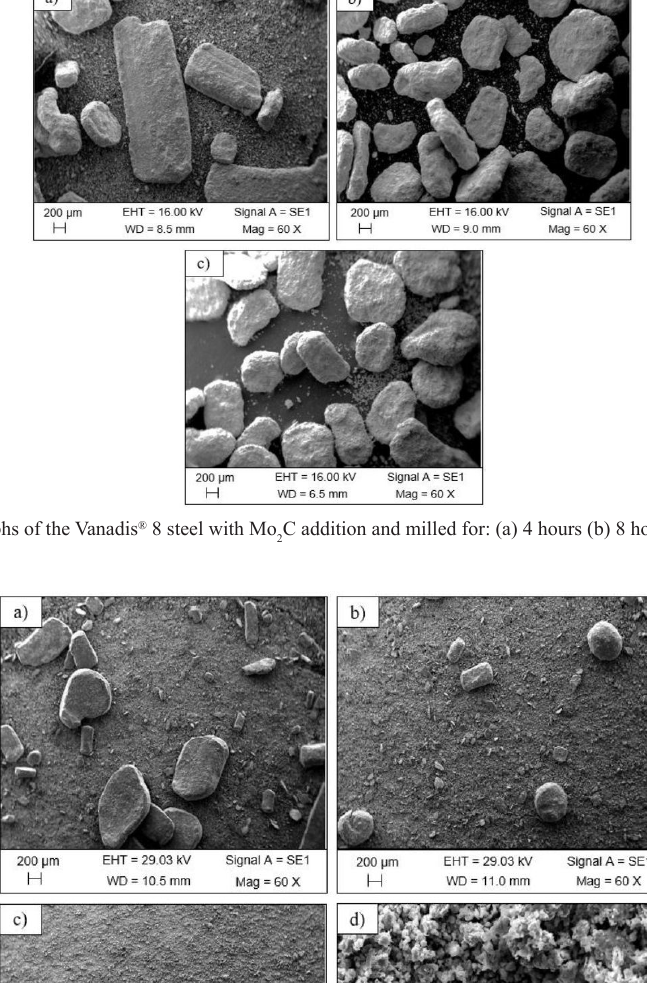
Figure 3: SEM micrographs of the Vanadis ® 8 steel with VC addition and milled for: (a) 4 hours (b) 8 hours (c) 12 hours (d) 12 hours with magnification of